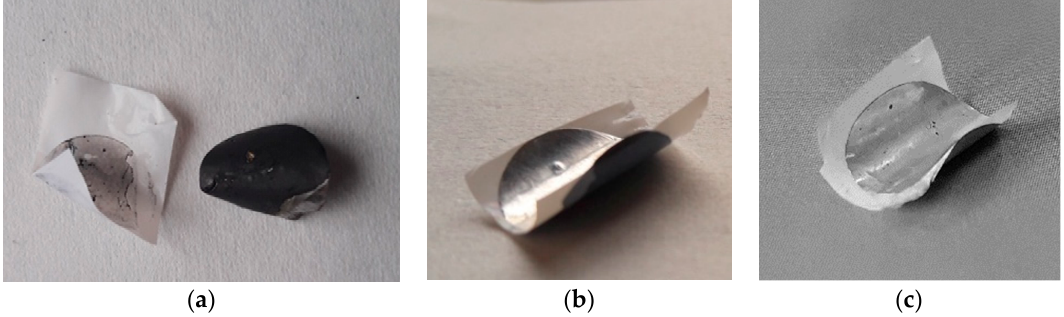
Figure 3. Images of the separators pressed onto the LNMO electrode: C2075 ( a ), CN01 ( b ), CP ( c ).